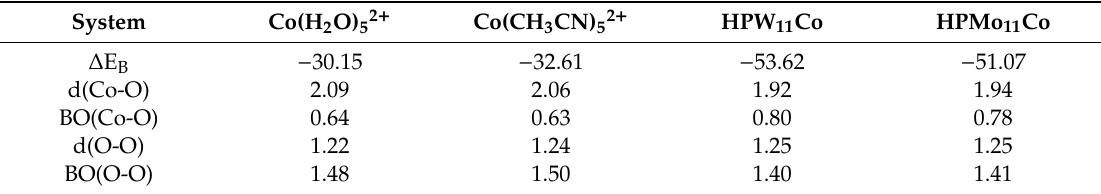
Figure 1. Thegeometricstructureofcomplexeswereobtainedasaresultofthemolecularoxygeninteraction Figure 1. The geometric structure of complexes were obtained as a result of the molecular oxygen with the studied systems: OO-Co(H 2 O) 5 2 + ( a ), OO-Co(CH 3 CN) 6 2 + ( b ), and HPW(Mo) 11 Co-OO ( c ). interaction with the studied systems: OO-Co(H 2 O) 52+ ( a ), OO-Co(CH 3 CN) 62+ ( b ), and HPW(Mo) 11 Co- OO ( c ). Table 1. The energetic (binding energy ∆ E B [kJ / mol] for the reactions (1–3)), geometric (bond length d(Co-O / O-O) [Å]) and electronic (Mayer bond order indexes BO) parameters characterize the bond between the metallic center (Co 2 + ) and the oxygen